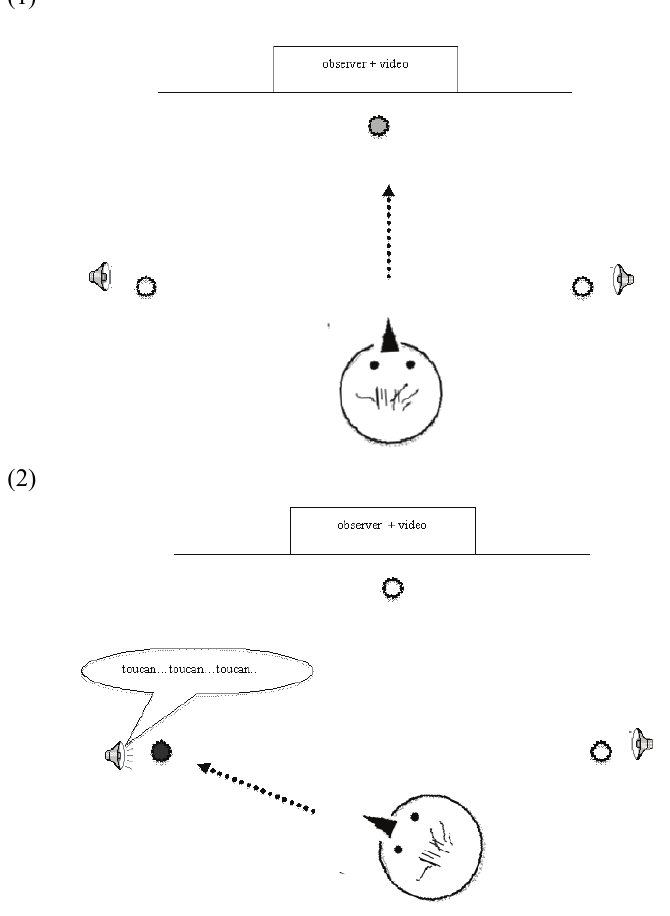
Figure 1. The headturn preference procedure (HPP) is based on the comparison of orientation/listening times to different kinds of stimuli. For each trial, the center light first blinks to bring infant’s attention to the center of the display; when the infant looks at the center, (1) one of the side lights starts blinking, when the infant turns to that light, (2) the stimuli are presented from the loudspeaker on the same side and orientation/listening times are recorded. In segmentation studies, infants are first familiarized with two words, and then tested with passages containing or not those words (the reversed passage/word order is also